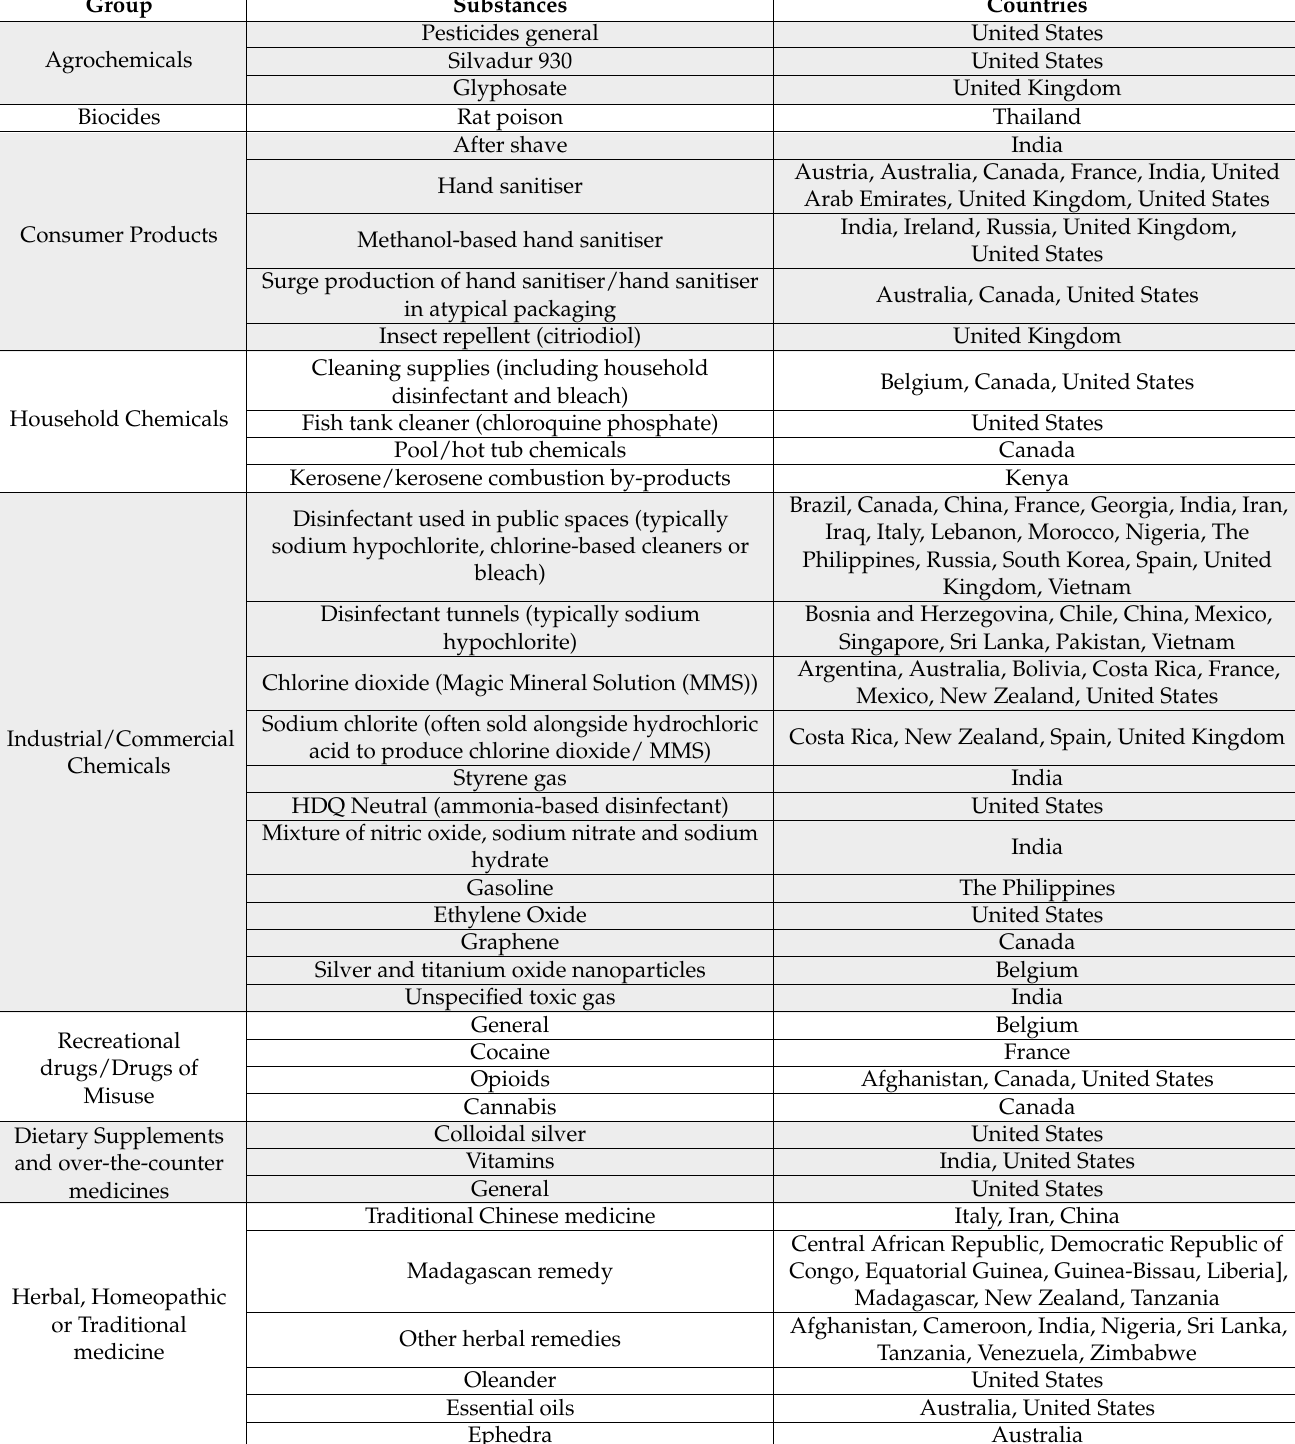
Table 2. Substances identified in poisoning cases or as a poisoning risk associated with COVID-19, as well as countries where this risk has been identified (more detailed results and associated references can be found in Supplementary Table S2, which provides a high-level summary of the context, poisonings and reports associated with each